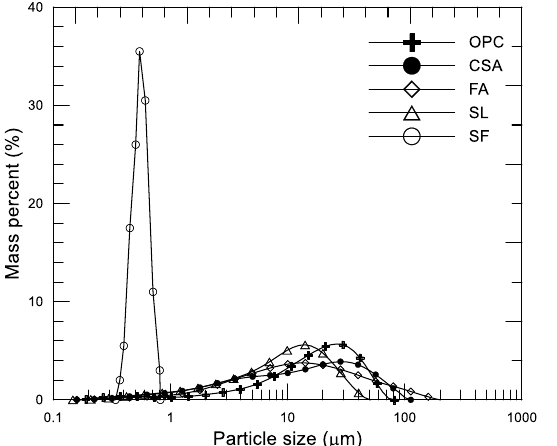
Figure 2. Size distribution of cements and supplementary cementitious materials (SCMs) used in the tests.